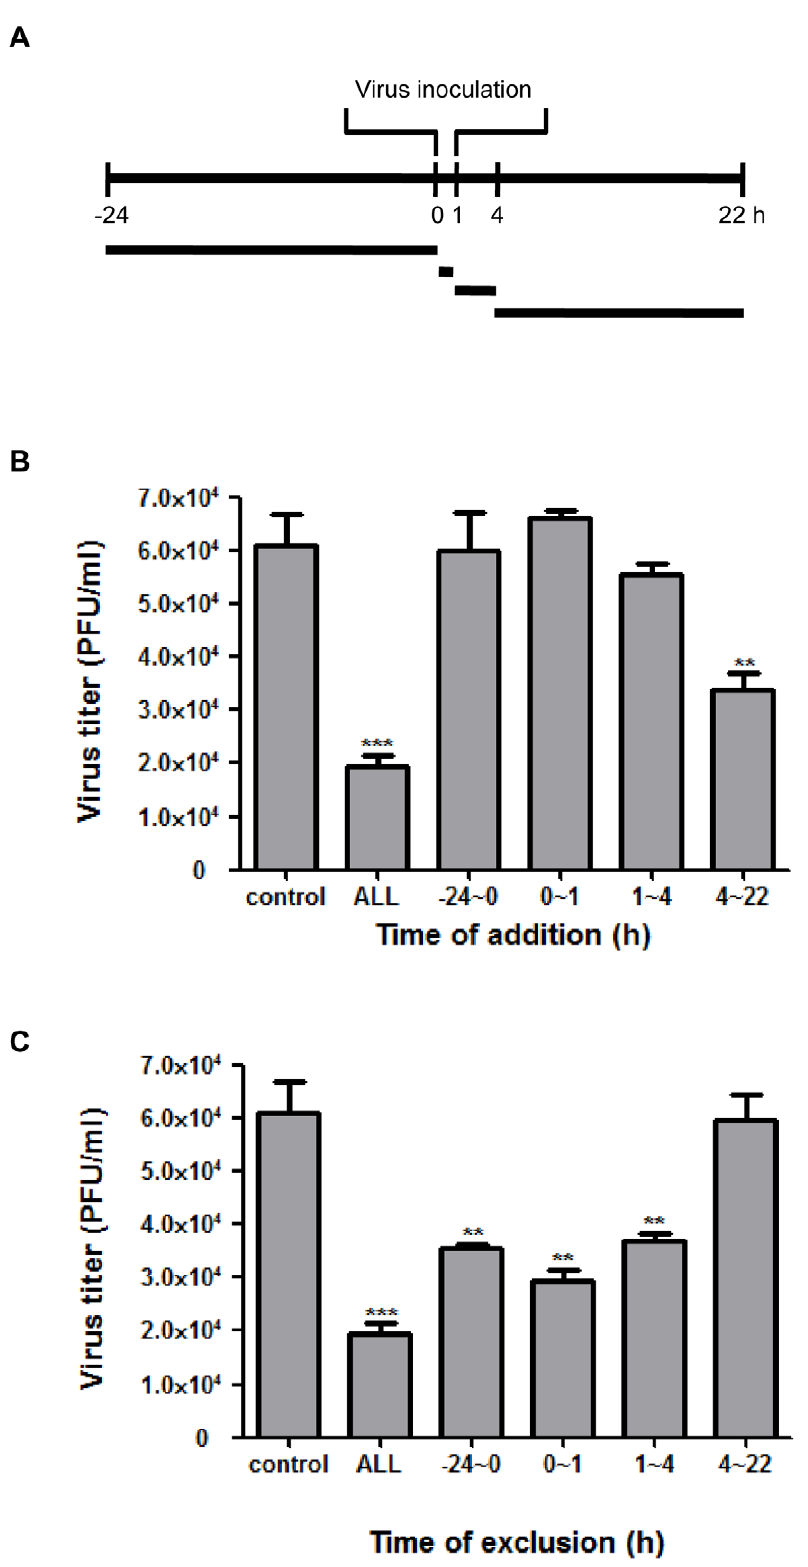
Figure 4. Meth reduces influenza A virus propagation at specific steps of the virus replication cycle. The assay to determine the effectiveness of meth in reducing influenza A virus replication with regard to the time-course of meth-exposure was performed in A549 cells as described in Materials and Methods. Cells were exposed to meth at 250 m M or left unexposed as the control (meth was not present in all incubation periods), followed by infection with influenza A/WSN/33 (H1N1) virus at an MOI of 1 PFU/cell in the absence of trypsin (single-cycle growth). Meth